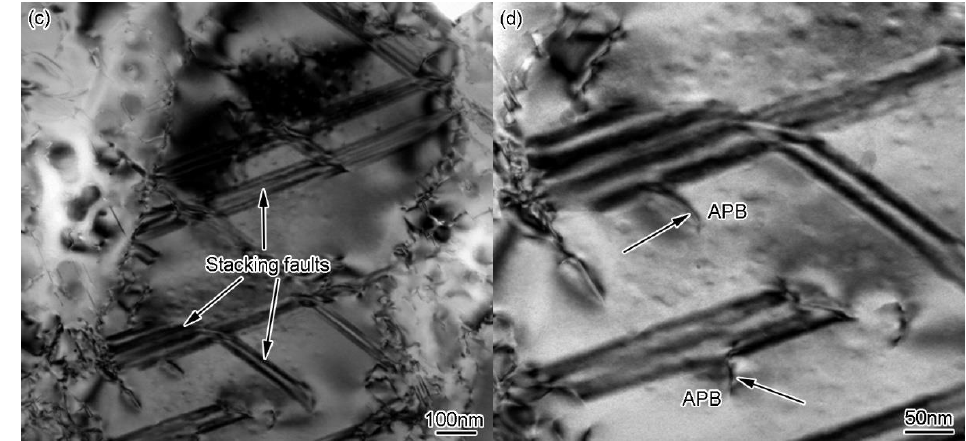
Figure 9. Transmission electron microscopy (TEM) images of dislocation morphology in HIPed alloy after creep under the condition of 705 °C/897 MPa: ( a ) dislocations and stacking faults, ( b ) and ( c ) stacking faults, and ( d ) the anti-phase boundary (APB).